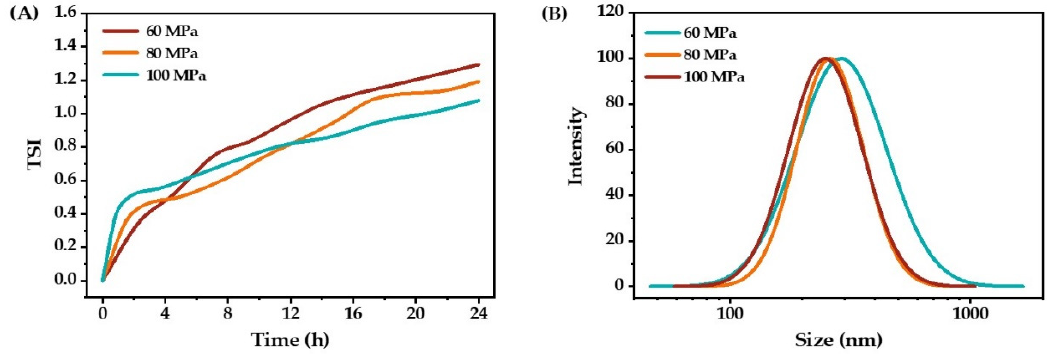
Figure 5. The stability ( A ) and droplet size distribution ( B ) of O/W emulsions prepared under different homogenization pressure. different homogenization